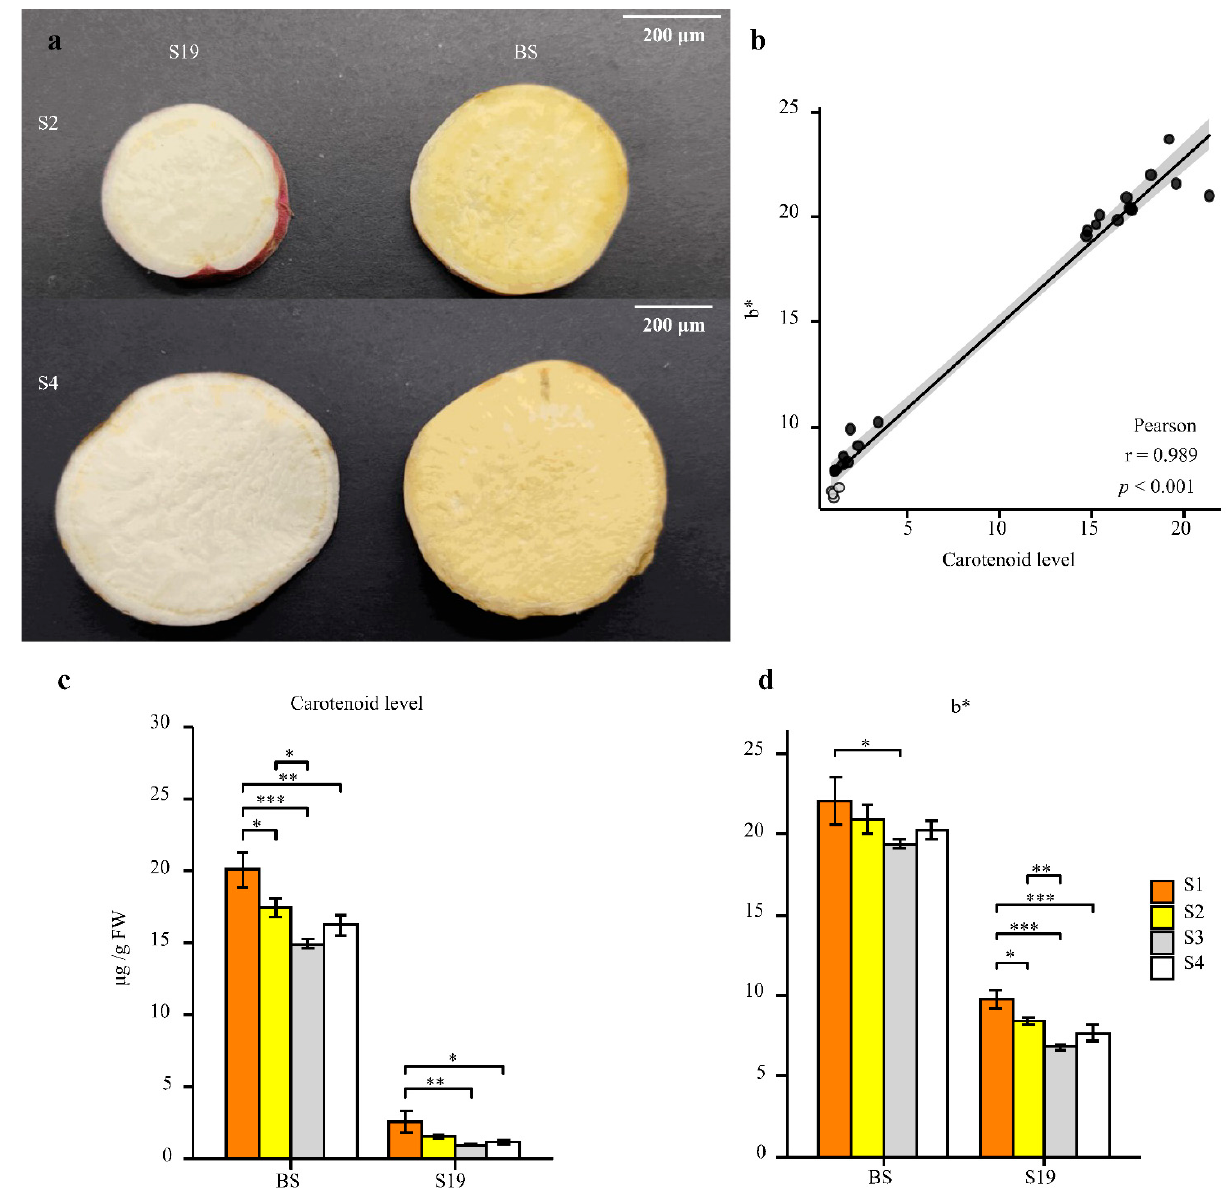
Figure 1. Analyses of sweet potato storage root phenotypic characteristics and carotenoid con- tent. ( a ) Storage root phenotypes were assessed for BS-S2, BS-S4, S19-S2, and S19-S4 samples. Scale bar = 200 µ m. ( b ) Correlations between carotenoid content and color change. ( c , d ) Total carotenoid content ( c ) and color change ( d ) were analyzed in both sweet potato types at the analyzed time points. Data are means ± SEM ( n = 3). *** p < 0.001, ** p < 0.01, * p < 0.05. When the annotated DEGs in these groups were subject to GO classification based on the molecular function (MF), biological process (BP), and cellular component (CC) annotation categories (Table S3), 3800 DEGs (885 MF, 2491 BP, and 424 CC), 3883 DEGs (898 MF, 2547 BP, and 438 CC), 3064 DEGs (728 MF, 2048 BP, and 288 CC), and 3329